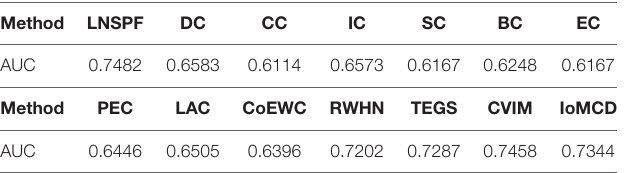
TABLE 6 | AUC values of LNSPF and 13 competing methods based on Krogan